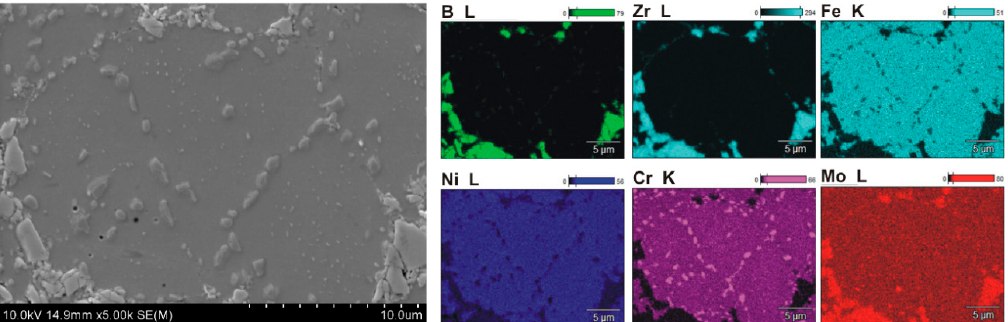
Figure 6. Microstructure and element surface distribution (Wavelength Dispersive Spectroscopy WDS) of steel +5%ZrB 2 composites.